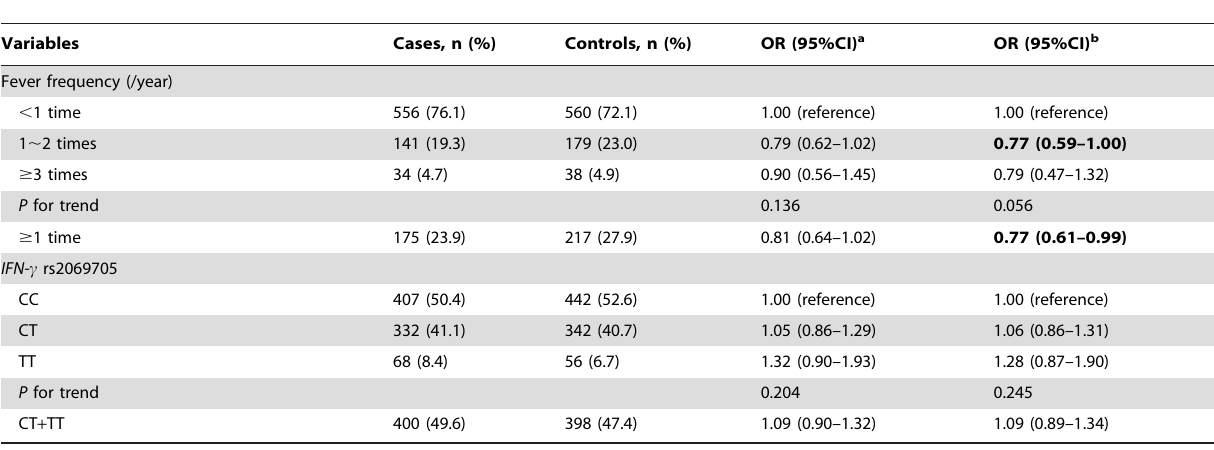
Table 2. Multivariate odds ratio of breast cancer risk associated with previous fever frequency and IFN- c genotypes.